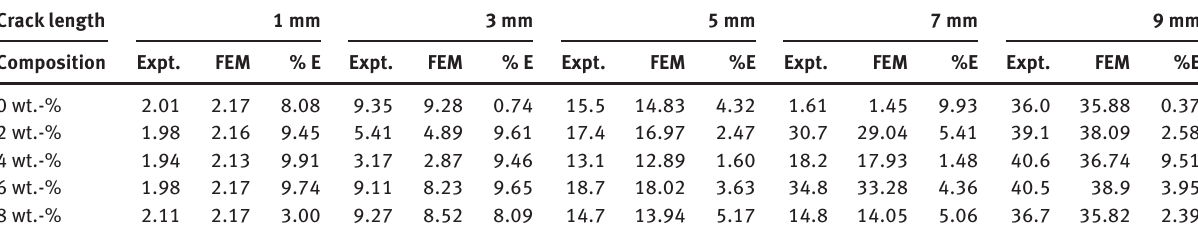
Figure 8 . The impact strength (in terms of impact energy absorbed in Joules during the Izod impact test) of micro- TiO -filled alloy composites decreased with the addition 2 of filler content in the composites (Figure 8). However, Sharma et al. [14] reported for zircon filled ZA-27 alloy composites that the impact strength increased with an increase in filler content because the impact strength of a material has a positive relationship with its ductility and is strongly influenced by the toughness of the matrix. The effect of TiO particulates is expected to be mechanical in 2 nature because the particulates are properly bonded with the matrix phase.